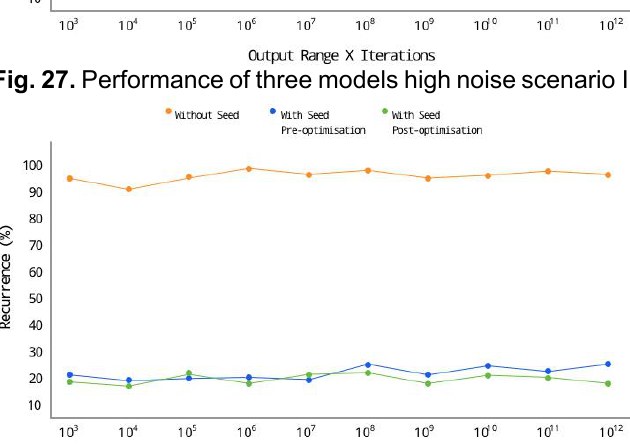
Fig. 27. Performance of three models high noise scenario II